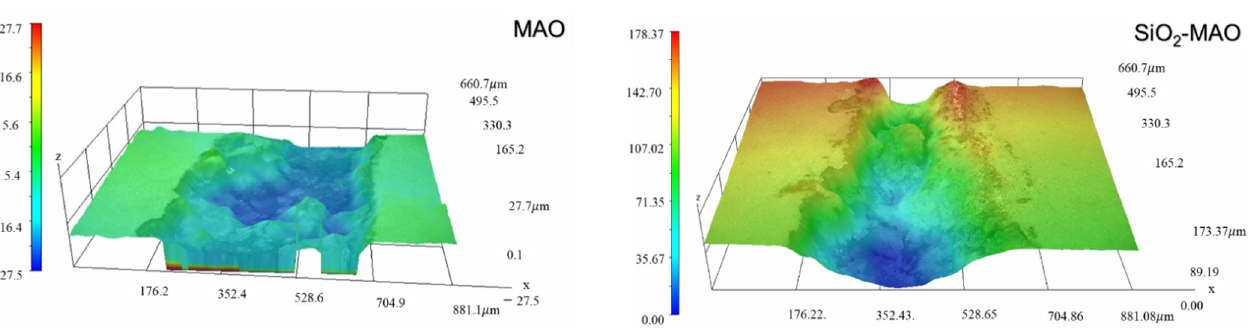
Figure 12. Local microscopic appearance of coating scratches.